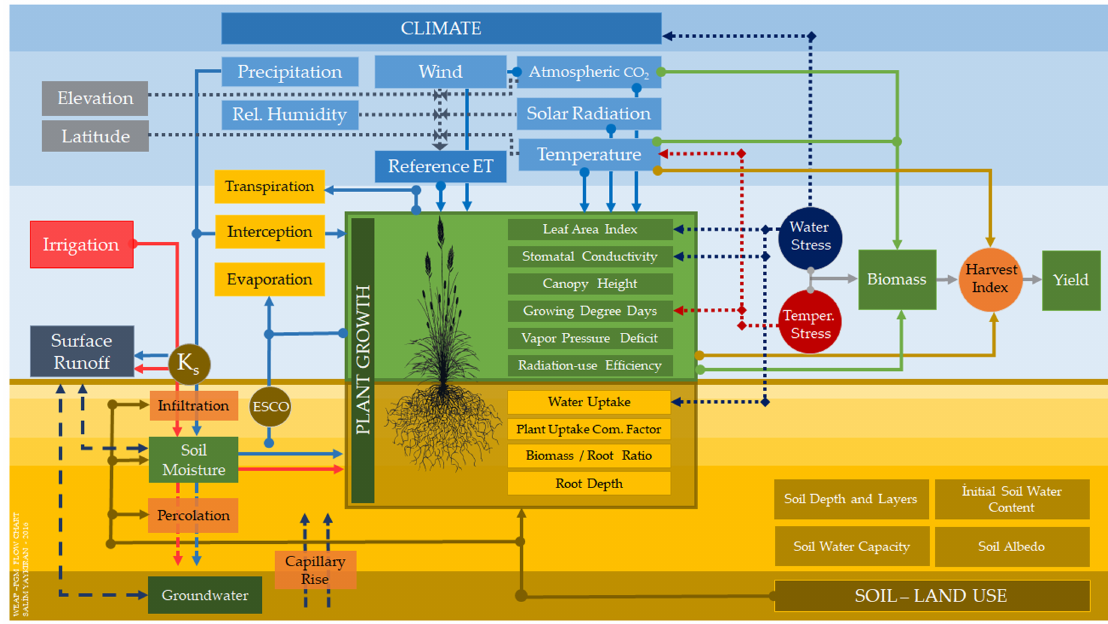
Figure 1. The structure of the conceptual WEAP Plant Growth